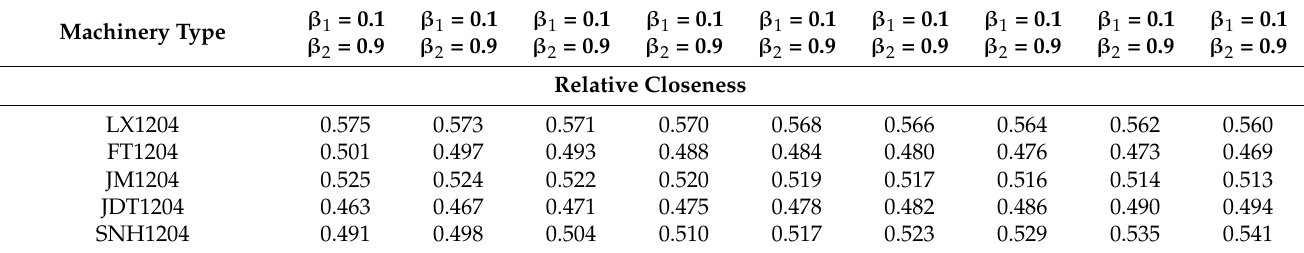
Table 7. Sorting of 88.2 kW power machinery types with different values of β 1 , β 2 .